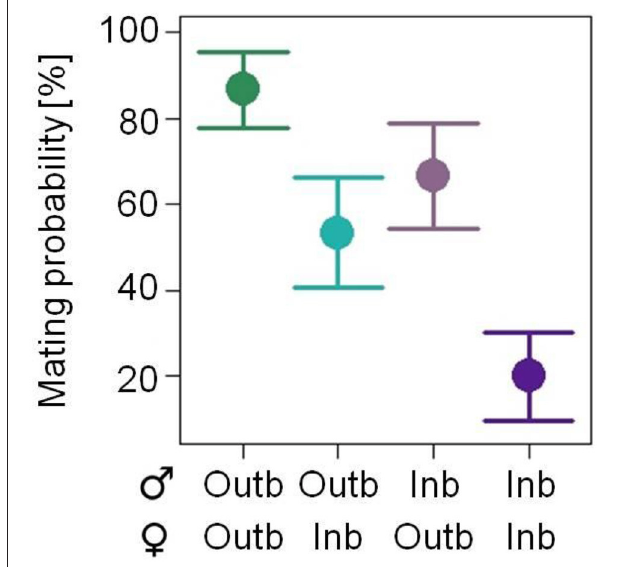
FIGURE 3 | Effects of the factor mating combination of either two outbred (Outb) mating partners (dark green), an outbred male and an inbred (Inb) female (light green), an inbred male and an outbred female (light purple) or two inbred mating partners (dark purple) of Phaedon cochleariae on the mating probability within 45min in a no choice situation ( N = 15 per combination; analyzed with a GLMM). The least square means with their standard errors (black dots with error bars) extracted from the minimal adequate GLMM are